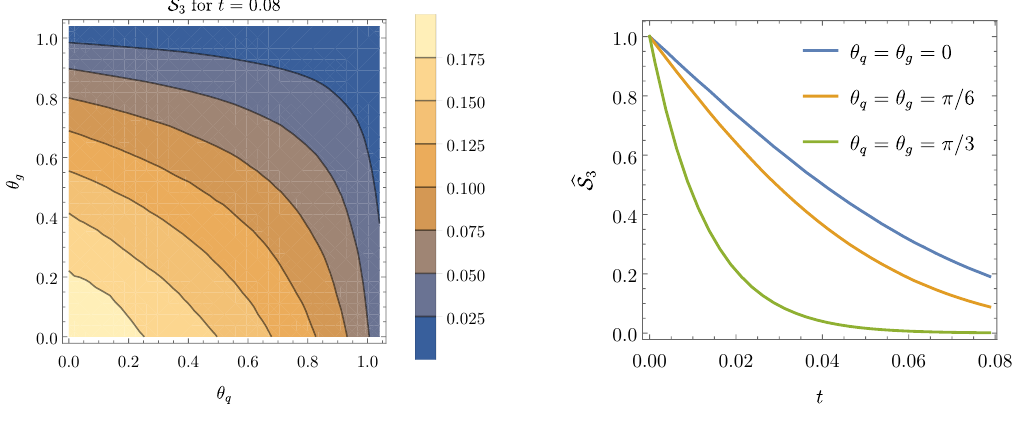
Figure 4 . Left: angular dependence of b S 3 for (cid:12)xed evolution time t = 0 : 08. Note that the angles (cid:18) q and (cid:18) g of the hard partons to the jet axis must be smaller than the cone angle (cid:11) = (cid:25)= 3 (cid:25) 1 : 04. Right: dependence on the evolution time t at (cid:12)xed